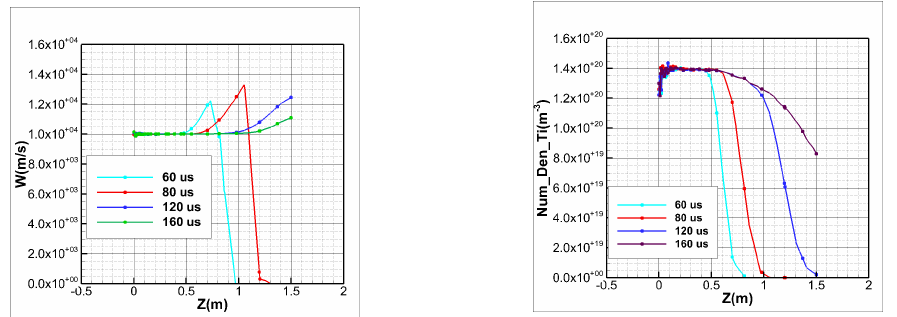
Figure 5. Velocity and number density distribution of atomic Ti at different times on the x = 0 plane.